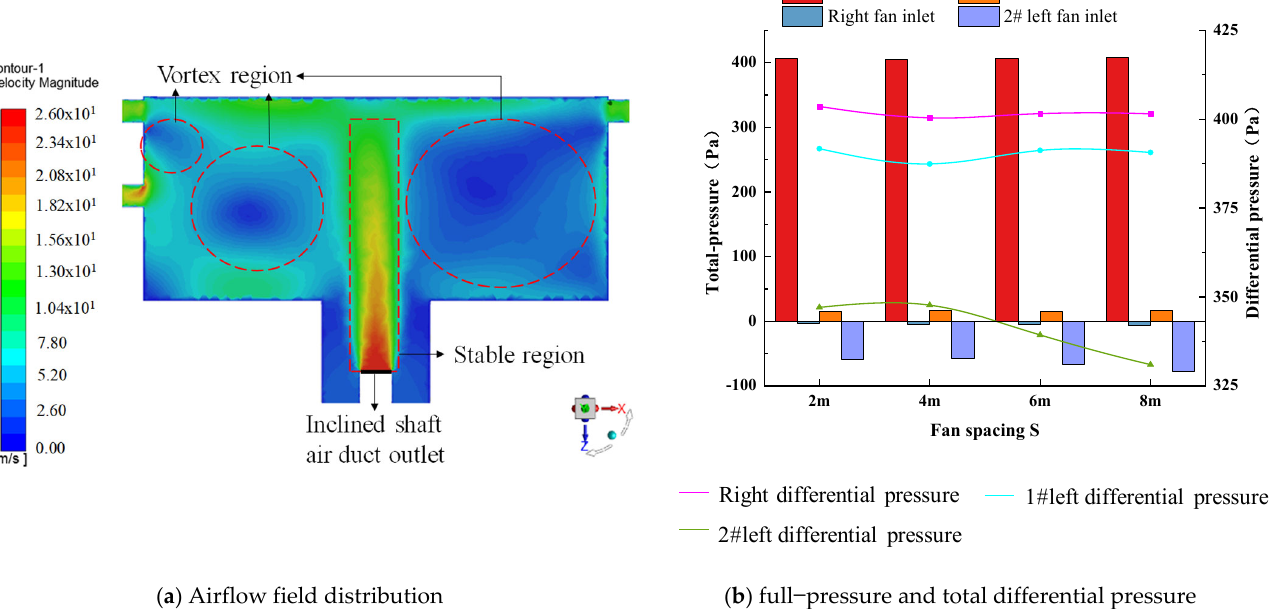
Figure 11. Airflow field distribution and differential pressure in different S.